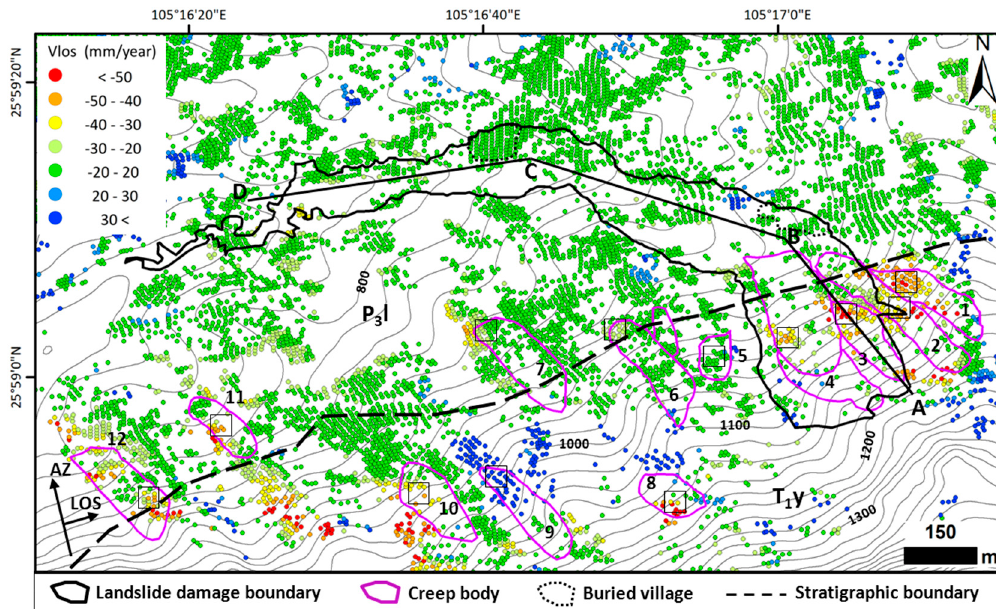
Figure 3. Average deformation rate before the occurrence of the Guanling landslide. The purple polygons represent the creep bodies detected using optical remote sensing images. The black polygon represents the landslide damage boundary. The two regions highlighted with dotted lines indicate buried villages, the dashed line shows the stratigraphic boundary, and the solid polyline ABCD marks the location of a profile, which will be discussed later. Note that the deformation is in the LOS direction, the negative values (red) imply movements toward the sensor, and the positive values (blue) imply movements away from the sensor.